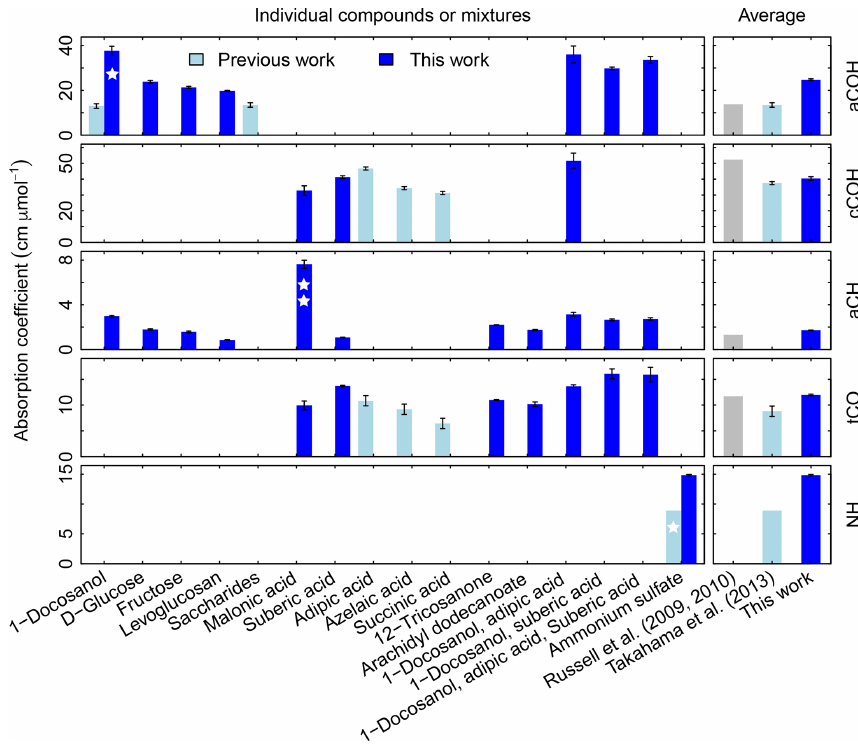
Figure 3. Summary of molar absorption coefficients reported in the literature. The single star for 1-docosanol aCOH indicates that there are only three points – one of which is an influential point – so this is effectively a single-point estimate. The single star for ammonium sulfate indicates that it based on a single value. The double star is used to indicate that the absorption coefficient for malonic acid cCOH is estimated for a concentration range order of magnitude lower than the rest. Previous studies are summarized by Takahama et al. (2013b), which also compiled coefficients from Gilardoni et al. (2007) and Russell et al. (2010). The error bars represent plus/minus one standard error of the molar absorption